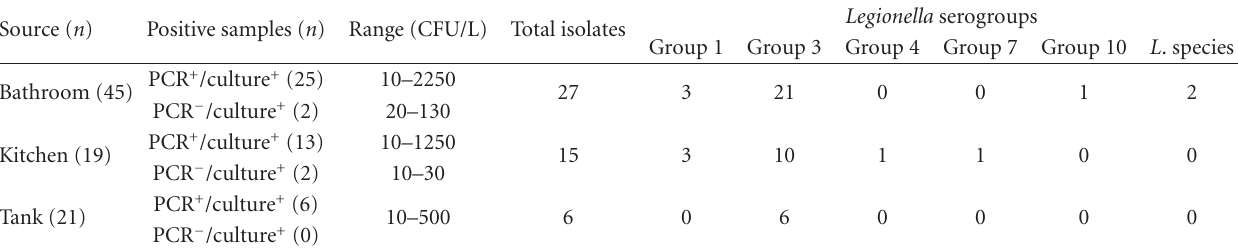
Table 2: Range of Legionella cells in positive samples and prevalent